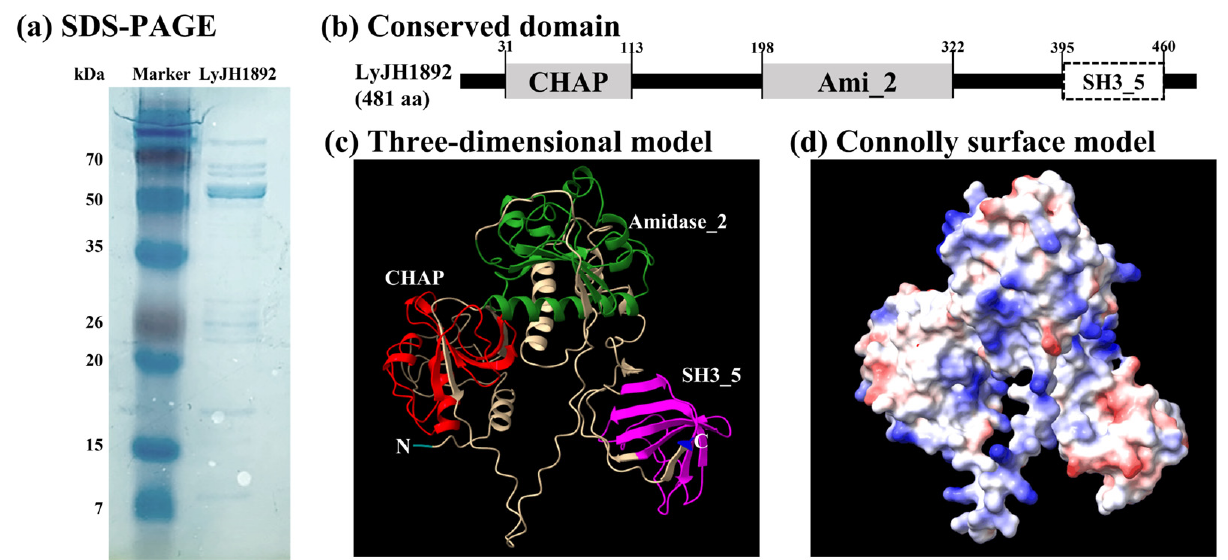
Figure 4. Structural characteristics of endolysin LyJH1892. ( a ) Analysis of endolysin LyJH1892 by sodium dodecyl sulfate-polyacrylamide gel electrophoresis. Lane 1 contained a protein molecular weight marker and lane 2 contained purified LyJH1892. ( b ) The conserved domain of LyJH1892. The gray square represents the enzymatically active domain, and the white square denotes the cell wall binding domain. ( c ) Three-dimensional model of LyJH1892, as predicted by AlphaFold2 using the Colab Fold notebook. ( d ) Connolly surface form of LyJH1892 created in ChimeraX 1.3. Blue and red colors represent the most positive and most negative polar activities, respectively.